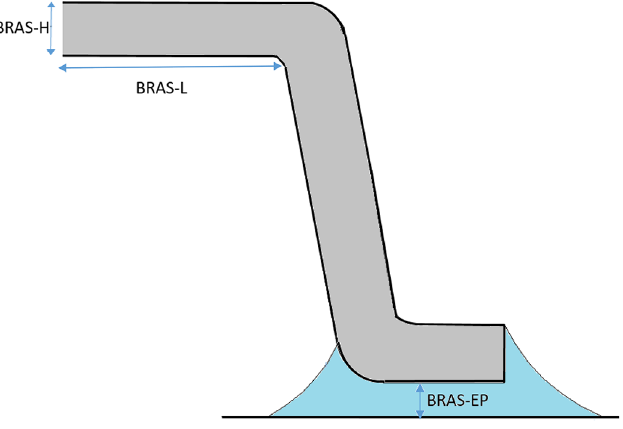
Fig. 9. Description of optimization parameters.